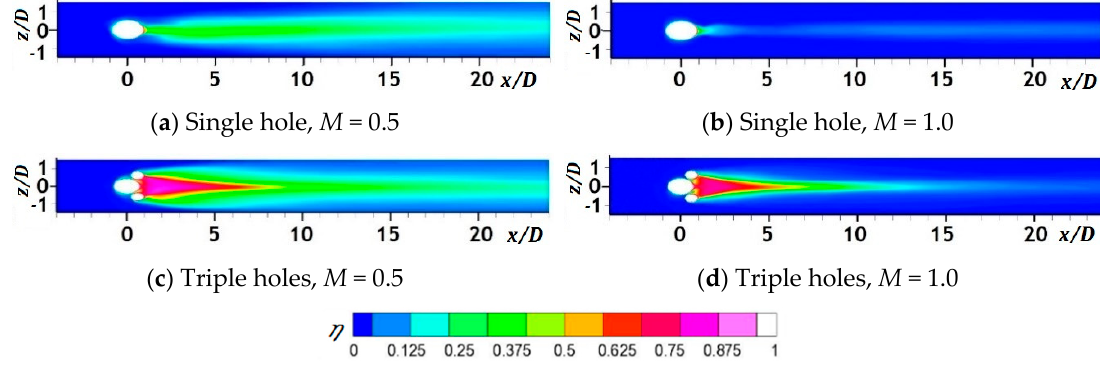
Figure 11. Time averaged film cooling e ff ectiveness on the test plate.